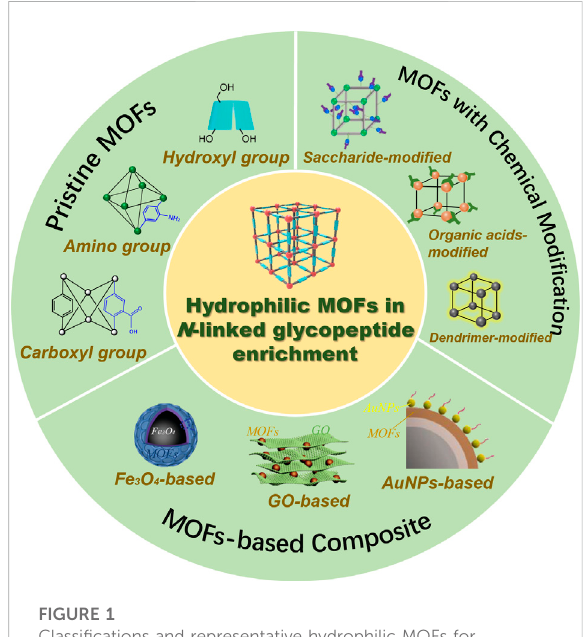
FIGURE 1 Classi fi cations and representative hydrophilic MOFs for N -linked glycopeptide